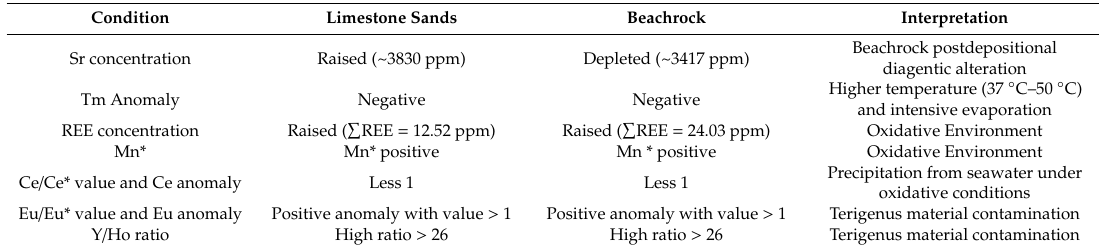
Table 4. Summary of deposition process a ff ecting the limestone sand and beachrock at Krakal-Sadranan, Yogyakarta,